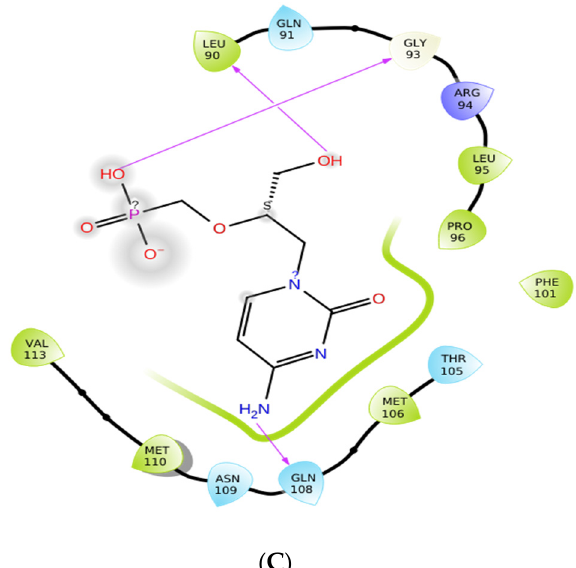
Figure 4. Image of the 2D interaction of the control compounds used for the comparison of the docking results, and proteins. ( A ) Chondroitin sulfate and D8L, ( B ) Tecovirimat and F13L, ( C ) Cidofovir and A6R.